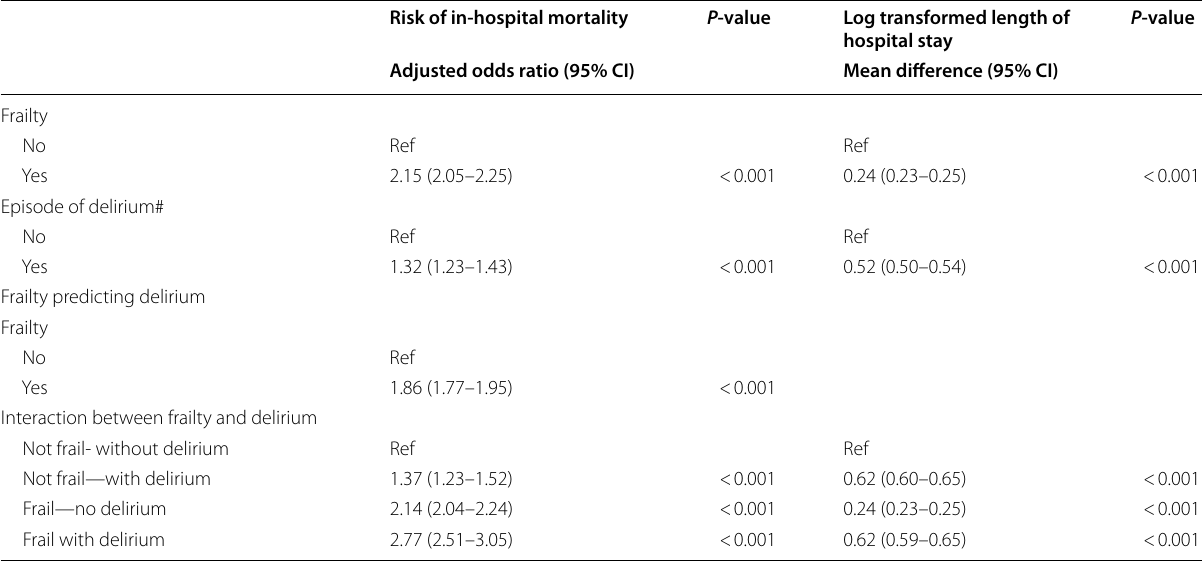
Adjusted for Australian and New Zealand Risk of Death (ANZROD). ANZROD is derived from patient and clinical characteristics, including the Acute Physiology and Chronic Health Evaluation (APACHE) III, ICU admission source, admission diagnoses, Acute Physiology score (APS), APACHE III chronic health score, treatment limitation, and ventilation status # Adjusted for ANZROD and